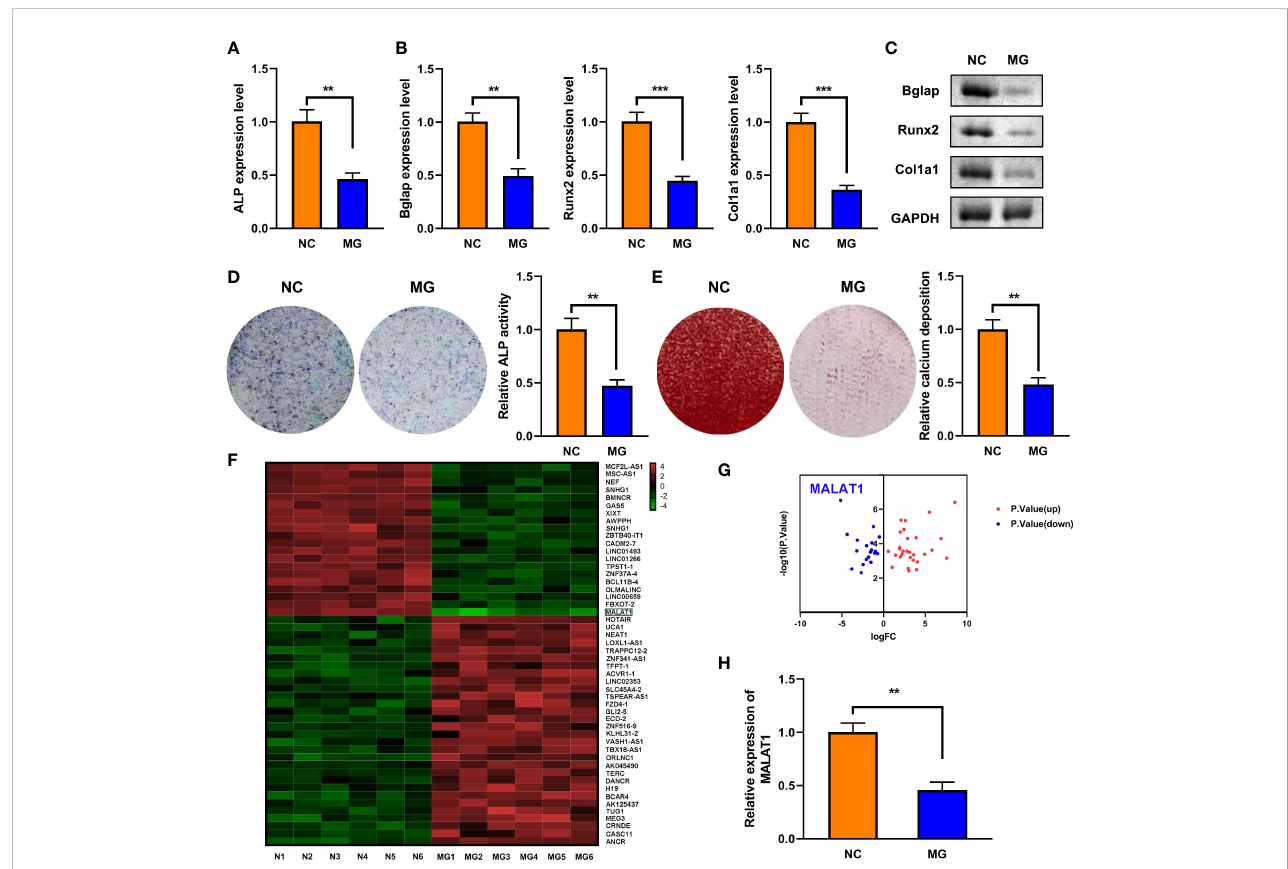
FIGURE 1 The expression of MALAT1 was downregulated MG-treated cells. (A) The expression of ALP in the MG-treated MC3T3-E1 cells was determined using RT- qPCR. (B) The mRNA expressions of Bglap, Runx2, and Col1a1 in the MG-treated MC3T3-E1 cells were measured by RT-qPCR. (C) The protein expressions of Bglap, Runx2, and Col1a1 in the MG-treated MC3T3-E1 cells were detected using Western blot. (D) ALP activity in the MG-treated MC3T3- E1 cells was detected using ALP staining. (E) Alizarin red staining was used to measure calcium deposit in the MG-treated MC3T3-E1 cells. (F, G) The differentially expressed lncRNAs in MG-treated MC3T3-E1 cells was expressed as heat maps and volcano maps. (H) The expression of MALAT1 in MG- treated MC3T3-E1 cells was detected using RT-qPCR. ** p < 0.01, *** p <